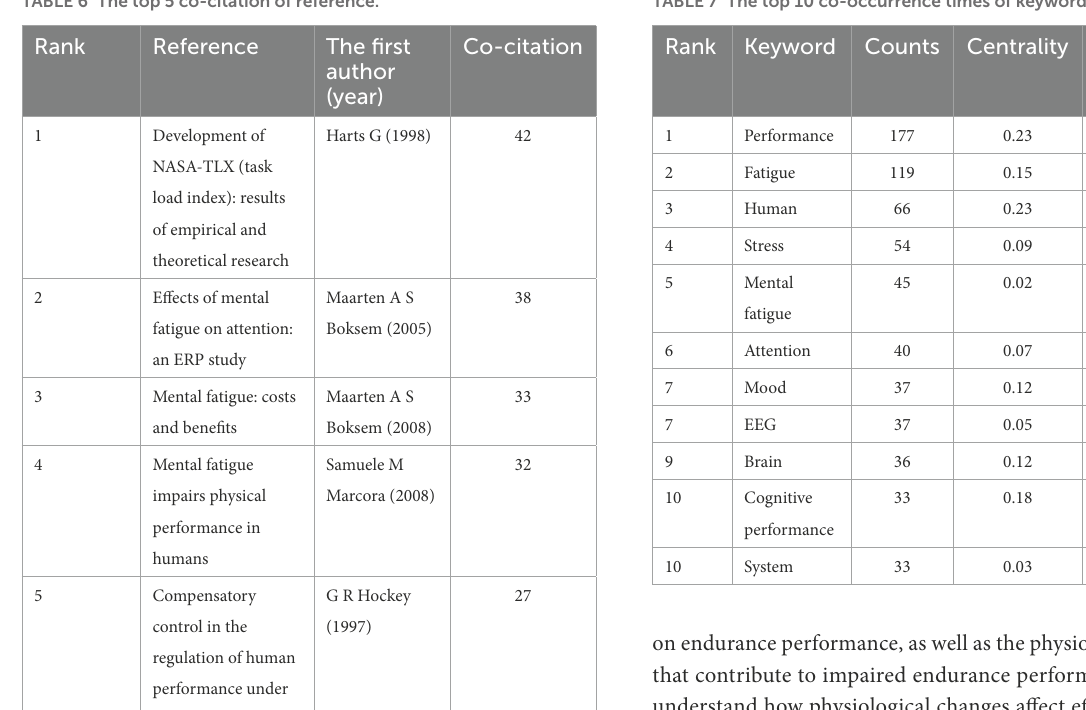
TABLE 6 The top 5 co-citation of reference.